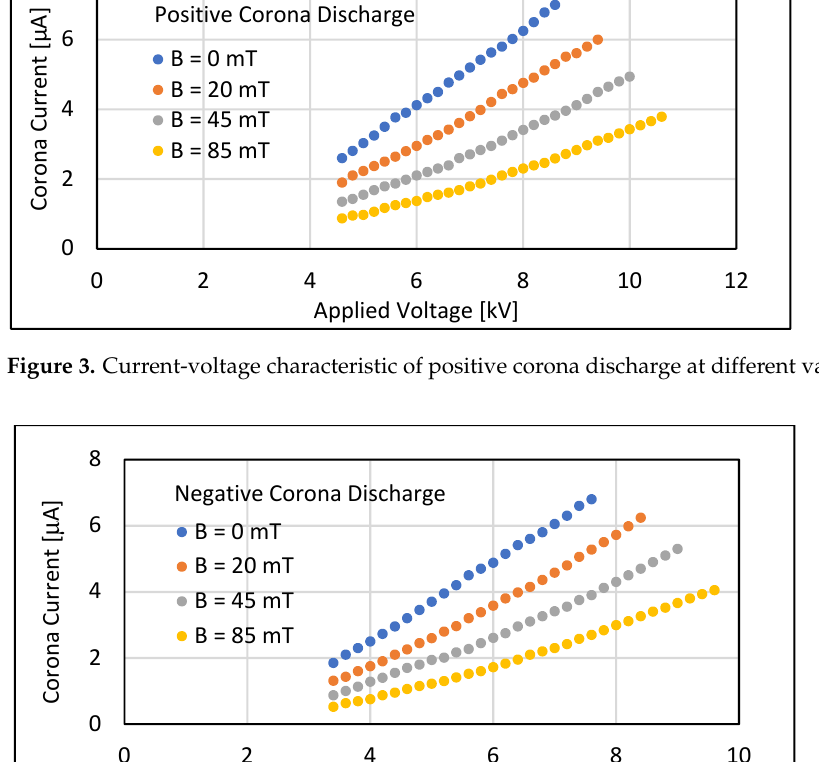
Figure 4. Current-voltage characteristic of negative corona discharge at different values of B.